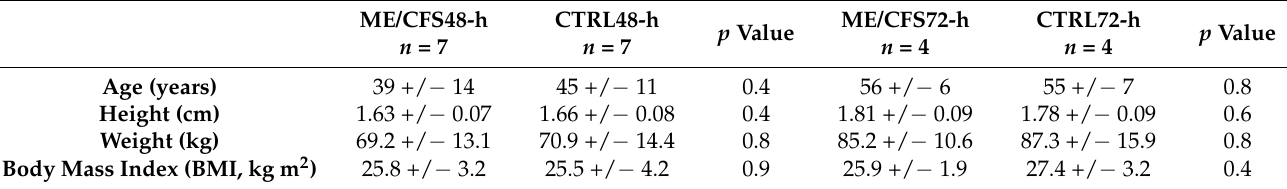
Table 1. Mean (standard deviation (SD)) of participant